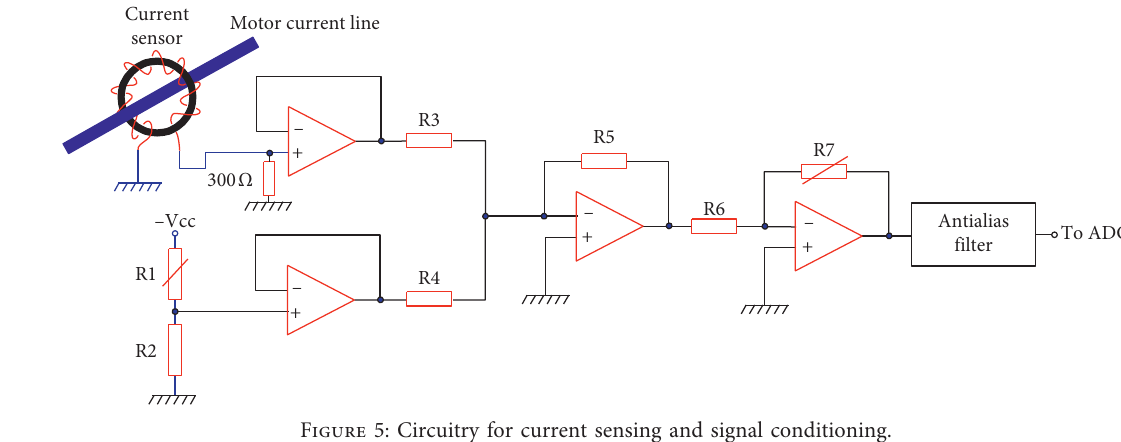
Figure 5: Circuitry for current sensing and signal conditioning.